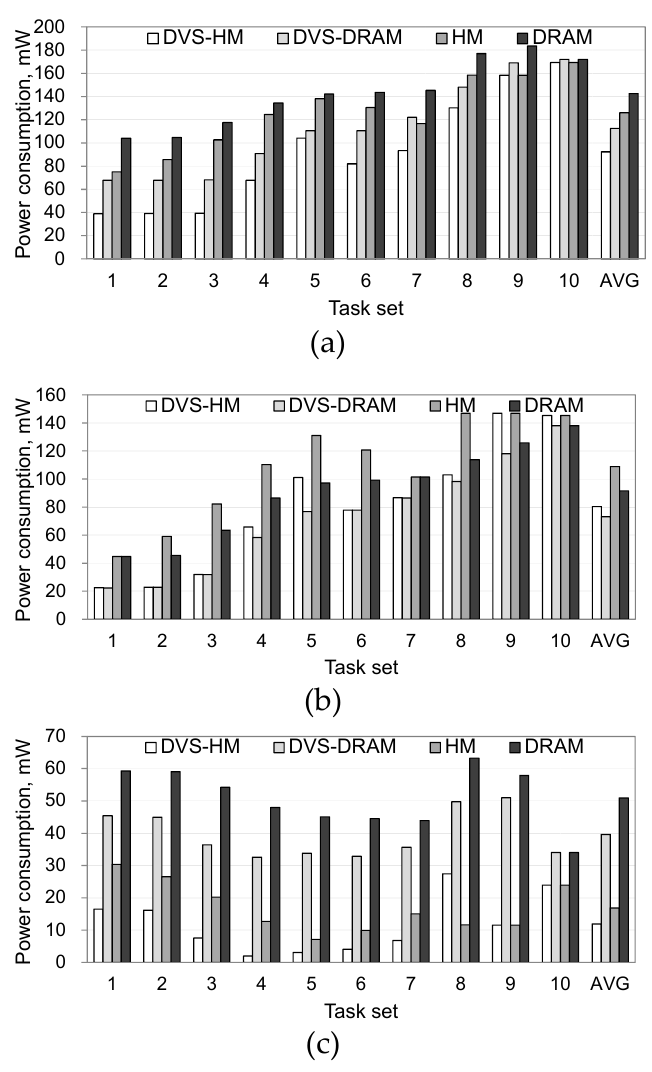
Figure 4. Power consumptions under synthetic workloads. ( a ) Total power consumptions, ( b ) active power consumptions, ( c ) idle power consumptions.